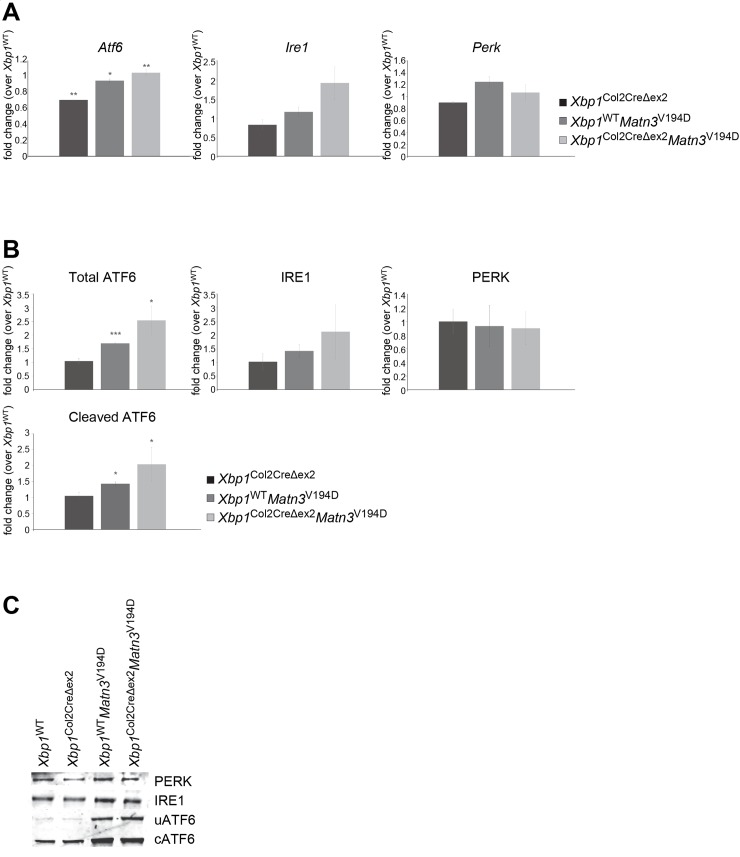
(A) Real time RT-qPCR data verifying expression levels of Atf6, Ire1 and Perk using mRNA extracted from 5 day old chondrocytes (n = 3, Student t-test). No detectable changes in Perk expression confirm lack of involvement of the PERK signalling pathway in EDM5 pathobiology. (B) Densitometry measurement of 3 biological replicates of Western blotting for ATF6, IRE1 and PERK, showing no difference in IRE1 and PERK protein levels in EDM5 cartilage with or without XBP1. Interestingly, the amount of total and active (cleaved) ATF6 was dramatically increased in EDM5 cartilage compared to wild type controls and upon further XBP1 deletion. (C) Representative Western blotting images. Key: * P<0.05, ** P<0.01, *** P<0.001, scale bar 100μm.